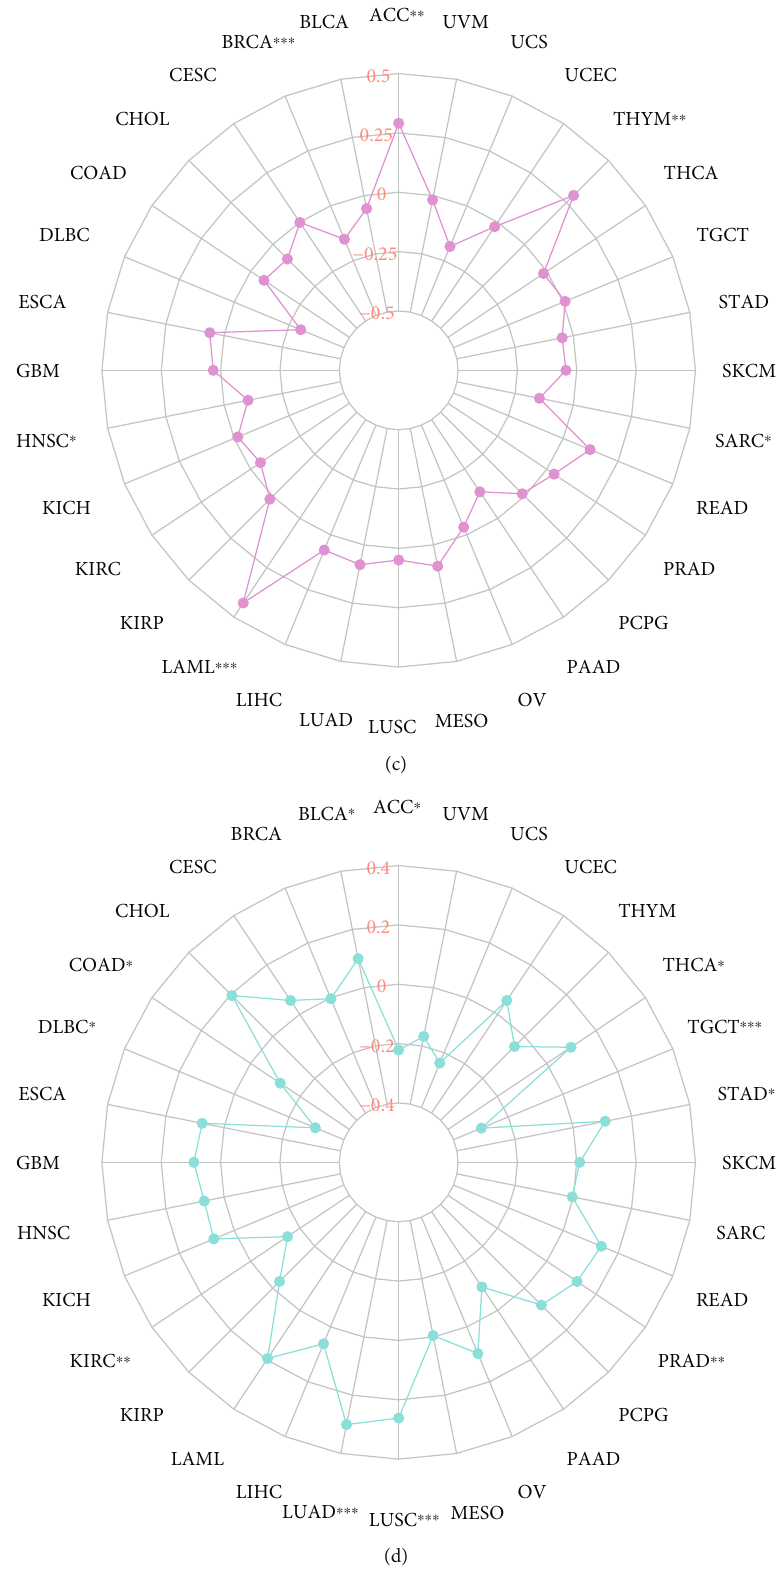
Figure 4: (a) Mutation characteristics of BACE1-AS in di ff erent carcinomas by using cBioPortal. (b) Detailed mutation information of BACE1-AS in mutated samples. (c) Correlation analysis of the expression level of TMB and BACE1-AS. (d) Correlation analysis of the expression level of MSI and BACE1-AS. ∗ P < 0 : 05 , ∗∗ P < 0 : 01 , and ∗∗∗ P < 0 : 001